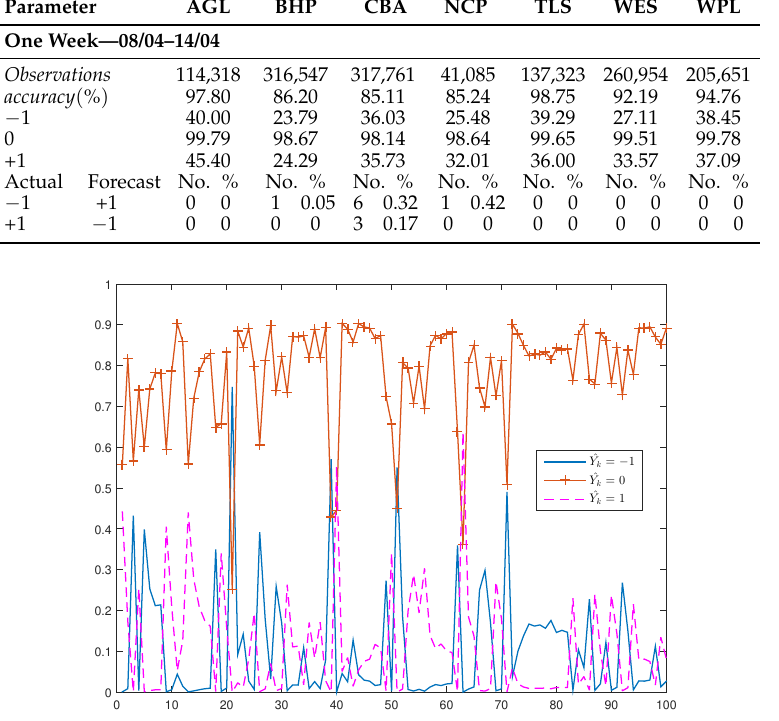
Figure 7. In-sample estimated probabilities of direction of price change for 100 observations of